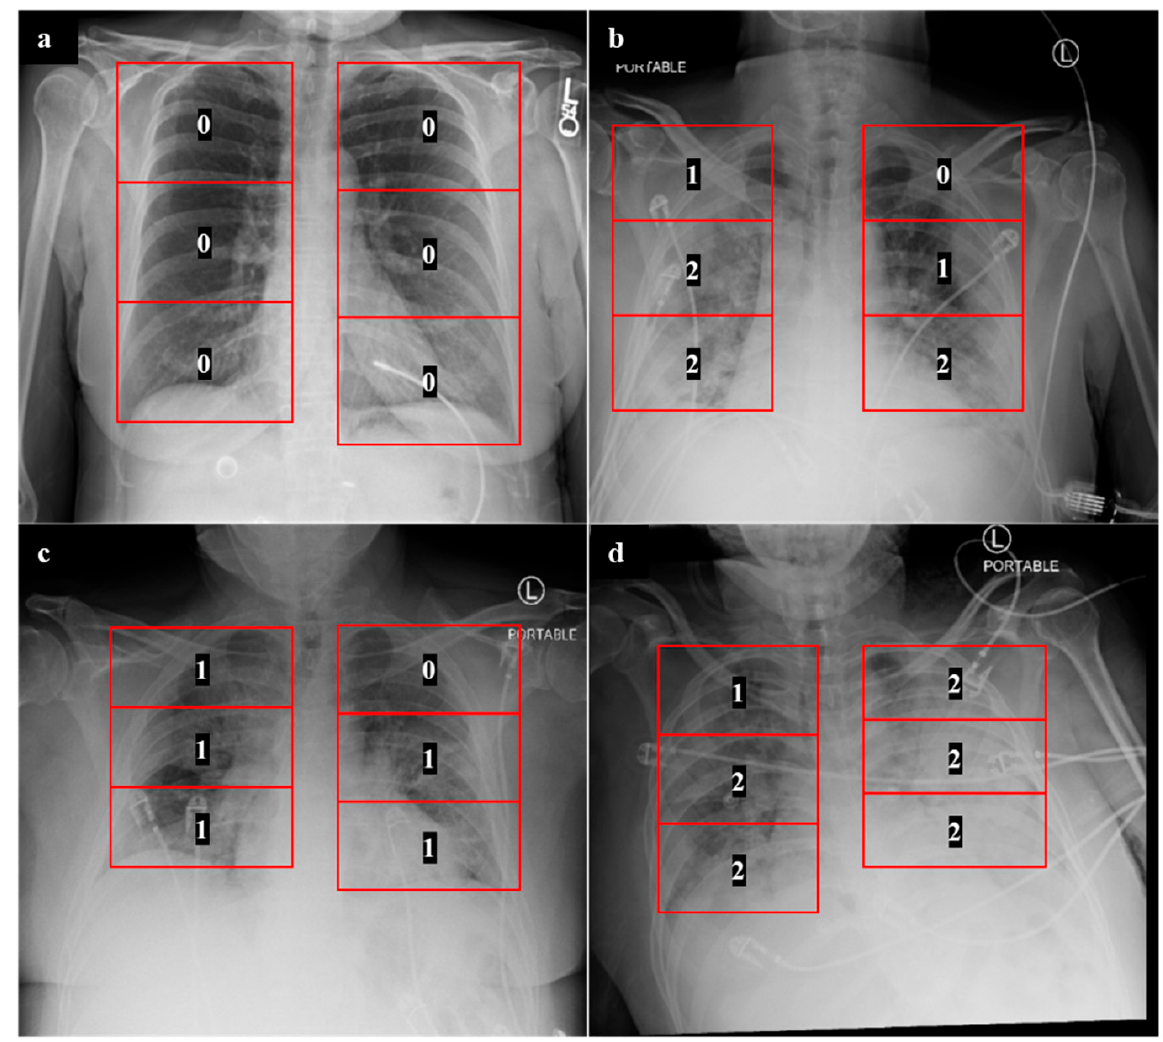
Figure 6. Zone-wise expert scores for CXRs. The numbers displayed are examples of zone-wise expert scores obtained for COVID-19 patients who ( a ) did not require mechanical ventilation and recovered, ( b ) required mechanical ventilation and recovered, and ( c , d ) required mechanical ventilation and are deceased.